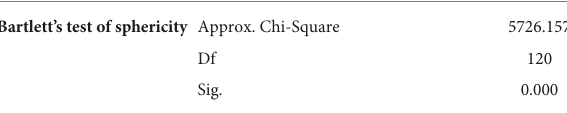
TABLE 3 Motivators for participating in yoga trips.